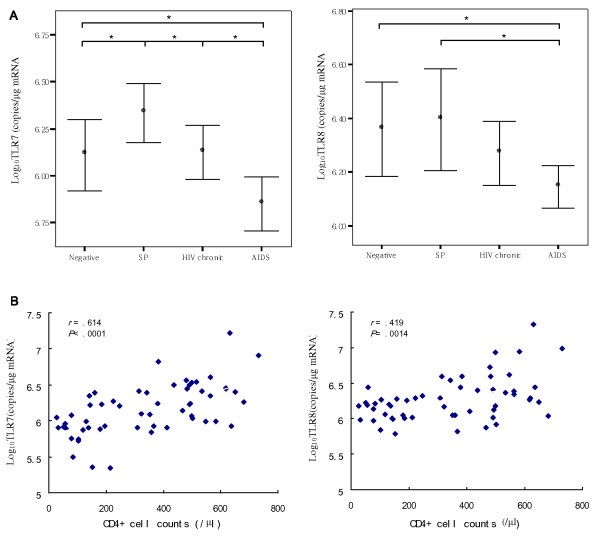
Expression of Toll-like receptor 7/8 in peripheral blood monocytes is associated with AIDS progression and correlates positively with CD4+ cell counts. (A) Expression of TLR7 was significantly increased in slow progressors (SPs) versus uninfected subjects, chronic HIV infected subjects, and subjects with AIDS. TLR7 expression was also significantly increased in subjects with chronic HIV infection versus AIDS. TLR7 in subjects with AIDS was significantly decreased compared to uninfected subjects. The expression of TLR8 was significantly decreased in subjects with AIDS compared with both uninfected subjects and SPs,*p < 0.05. Comparisons were made with one-way ANOVA LSD tests. All data are expressed as the mean ± SEM values from experiments performed in triplicate. (B) The expression of TLR7 and TLR8 was significantly correlated with CD4+ cell counts. Data was analyzed using the Spearman rank correlation with a level of significance of α = 0.05.